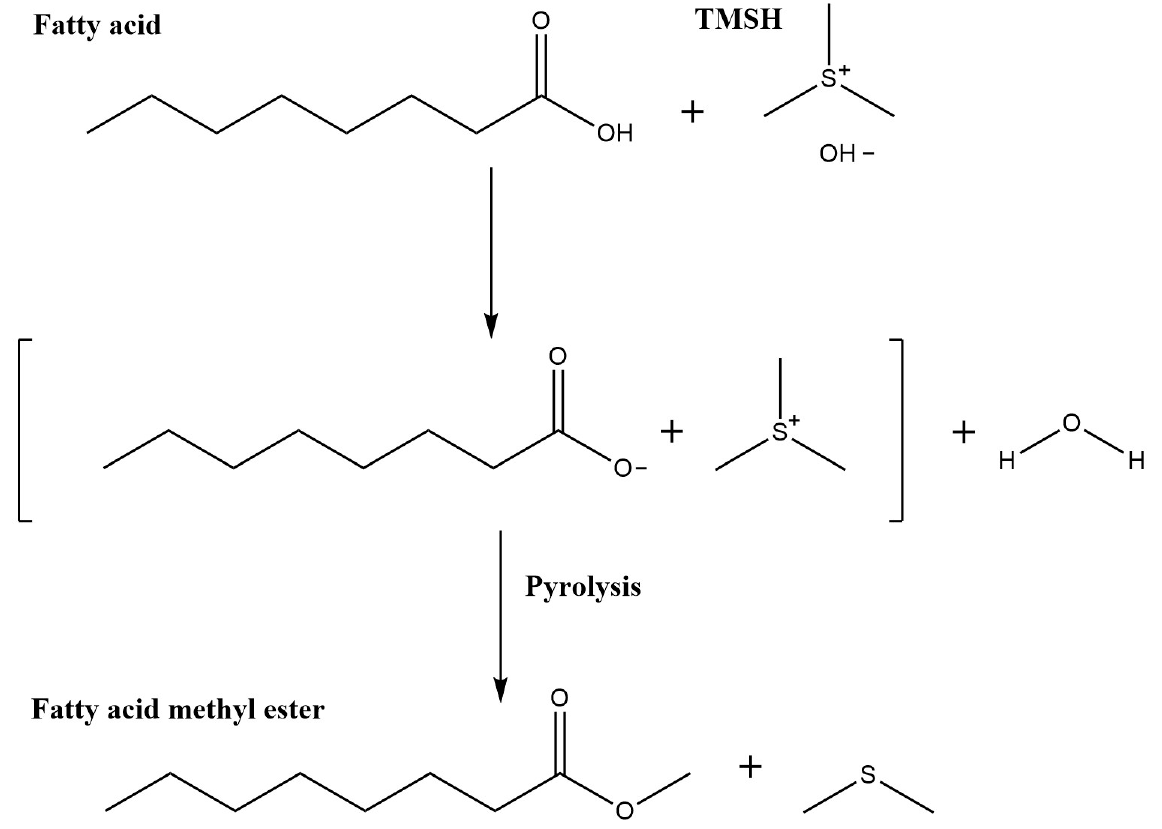
Figure 2. TMSH reaction outline for the conversion of fatty acids into fatty acid methyl esters by base-catalyzed transesterification and pyrolysis.